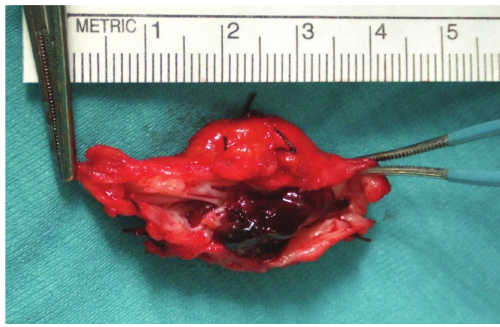
Figure 3: Small Saphenous vein aneurysm excised.